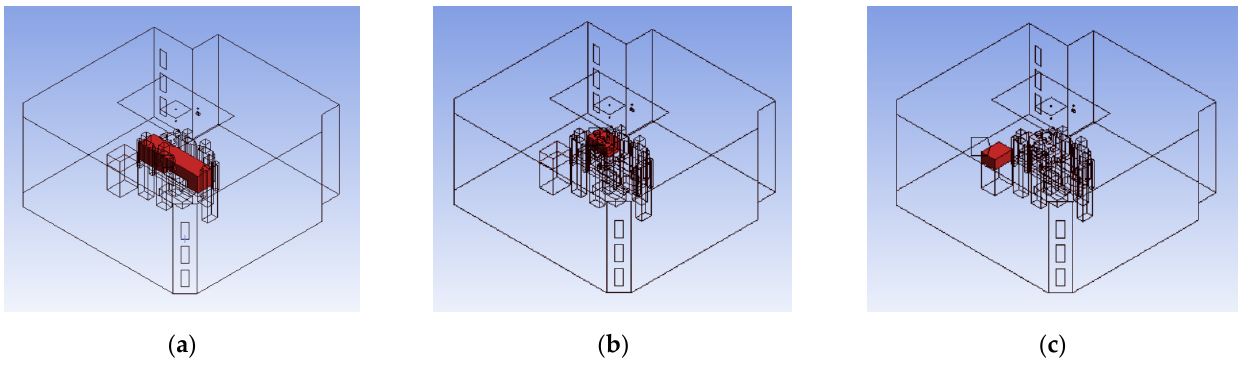
Figure 3. Reference volumes for monitoring the number of particles in the clean zone: ( a ) V OT ; ( b ) V IT 1 ; ( c ) V IT 2 .